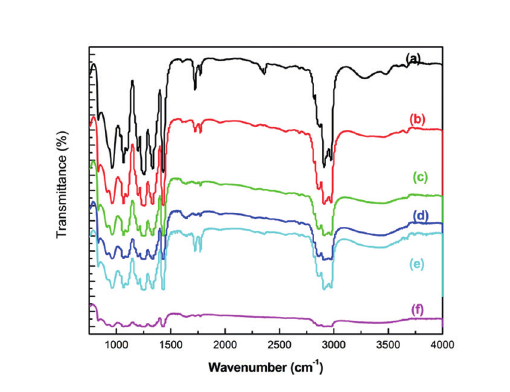
Figure 4: FTIR patterns of pure and Mn 2+ doped PVC polymer films (a) pure (b) 1mol% (c) 2 mol% (d) 3 mol% (e) 4 mol% (f) 5 mol%.